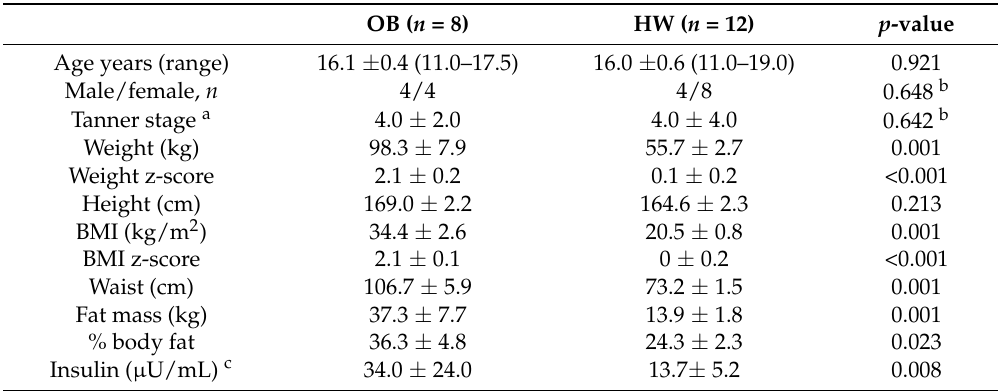
Table 1. Baseline